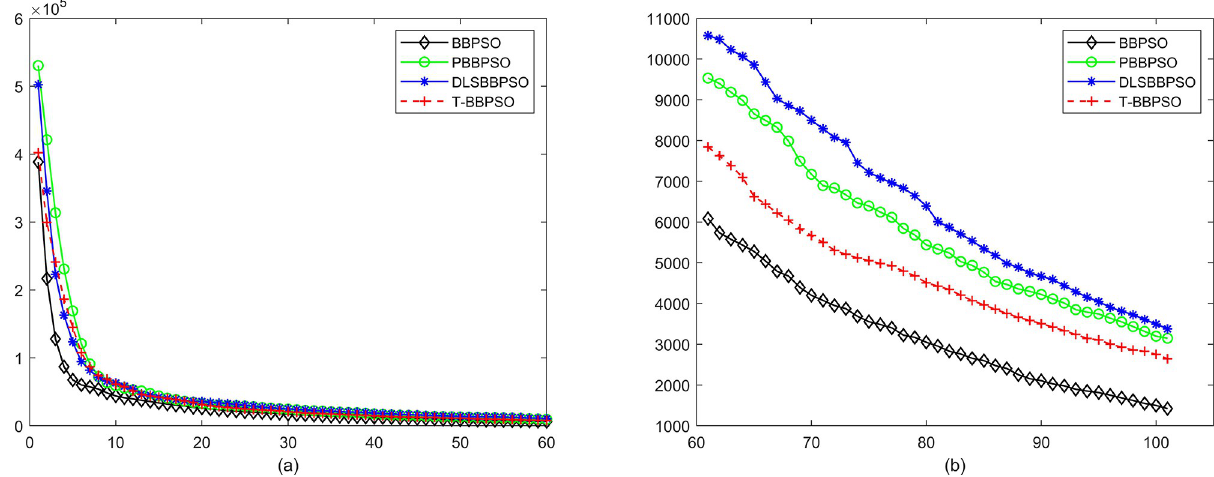
Fig 5. Comparison of convergence speed between BBPSO, PBBPSO, DLS-BBPSO and TBBPSO, f 3 , (a) iteration 0–6000, (b) iteration 6000–10000 the unit is 100 iteration.